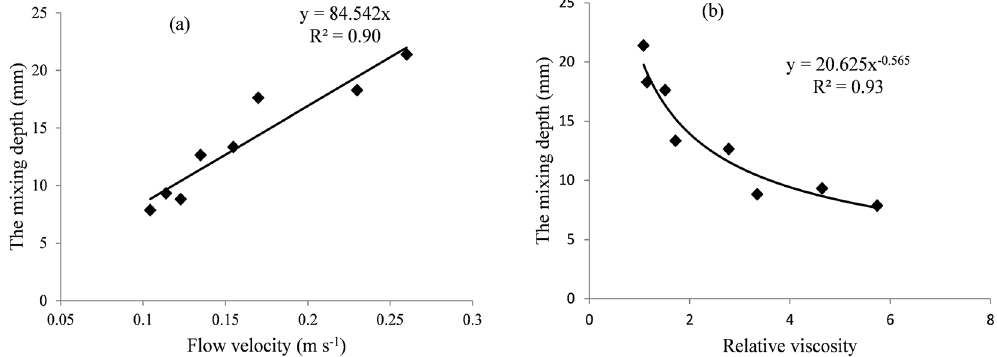
Figure 5. The mixing depth as a function of flow velocities and relative viscosity. Symbols = data; lines = fitted regressions.